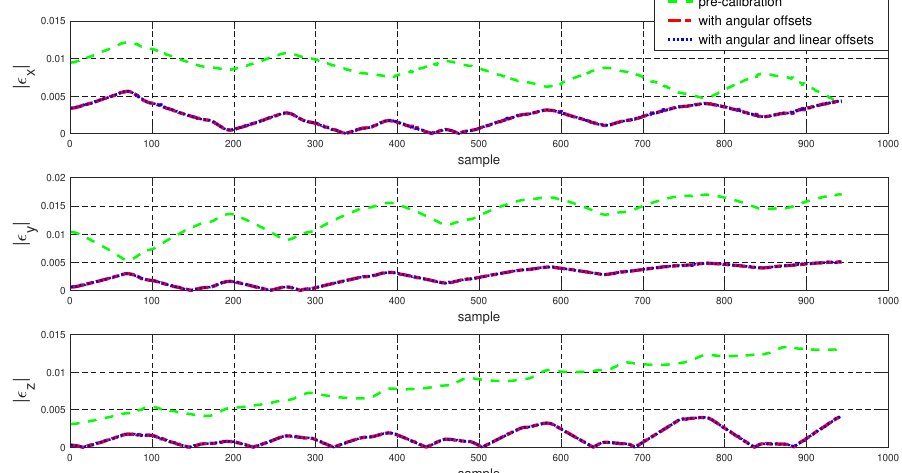
Figure 16. Resultant error in end-effector orientation error ( R T (cid:101) R − I ) ∨ for the training dataset before and after